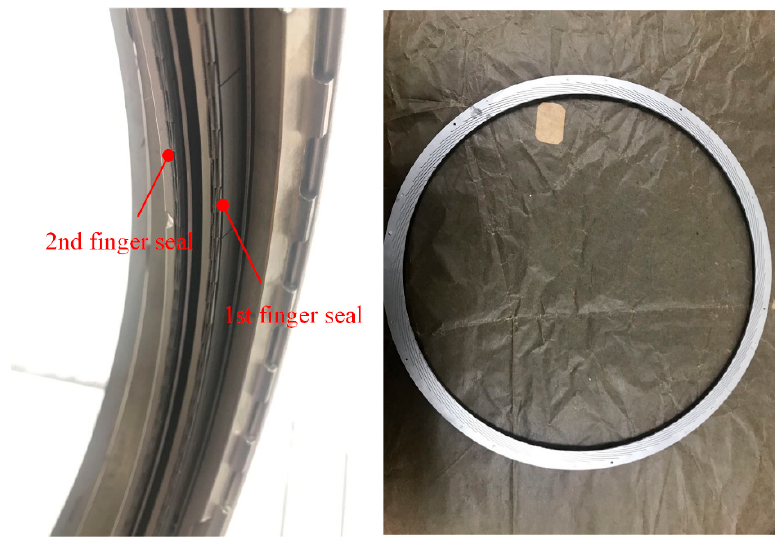
Figure 10. Test 2SFS.